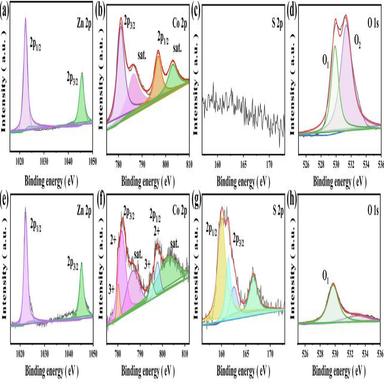
XPS spectra of ZnO/CoO: (a) Zn 2p, (b) Co 2p, (c) S 2p and (d) O 1s; XPS spectra of ZCSd-9h: (e) Zn 2p, (f) Co 2p, (g) S 2p and (h) O 1s.